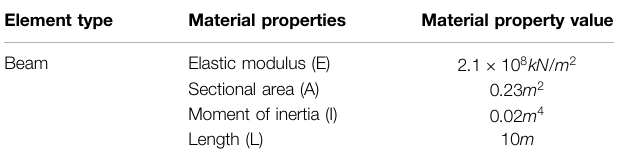
TABLE 1 | Table of the structural unit material property.